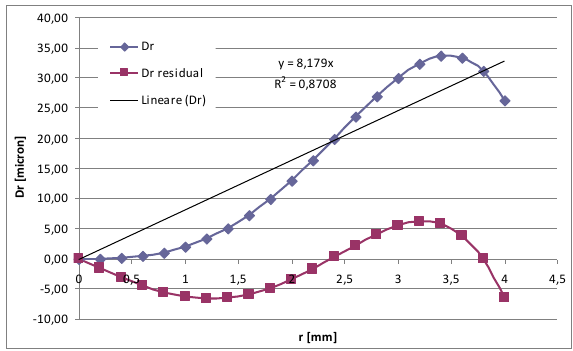
Figure 3 - Results of radial lens distortions of iPhone calibration